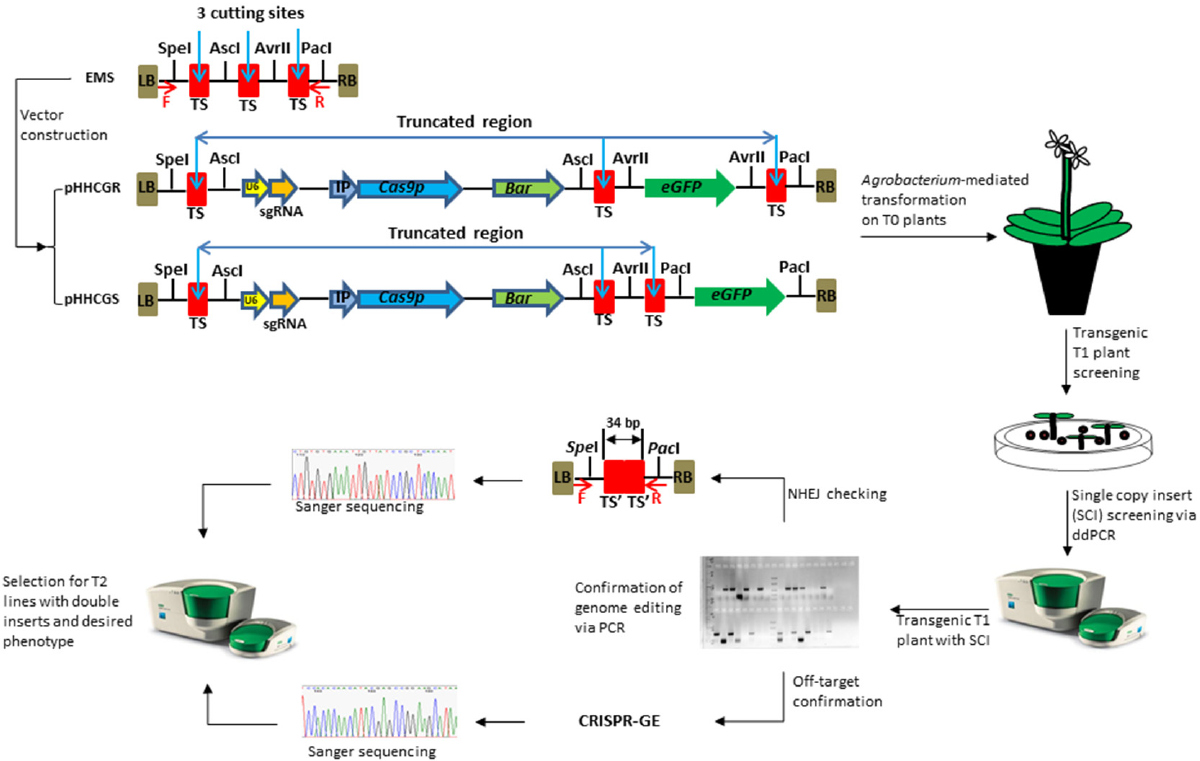
Figure 1. Vector design of a CRISPR/Cas9-based genome editing system with the controllable auto- excision feature and workflow to generate novel cisgenic germplasms. The embedded multi-clonal sequence (EMS) enables the controllable auto-excision. EMS was fully synthesized and cloned into the backbone of the plasmid pYLCRISPR/Cas9Pubi-B [31]. Different components were amplified individually and assembled into different restriction sites depending on their fate in the final product, i.e., removal (sites of AscI and AvrII) or retention (site of SpeI and PacI). LB/RB, T-DNA left/right border; TS, sgRNA targeted sequence (i.e., cutting site by Cas9 protein), originally 23 bp including PAM sequence; TS’, a 17 bp remaining sequence of TS after cutting. The vector pHHCGR and pHHCGS use eGFP to demonstrate controllable auto-excision in Arabidopsis thaliana (L.) Heynh. where the gene-of-interest is removed (pHHCGR) or retained (pHHCGS) in the final product. U6 ,